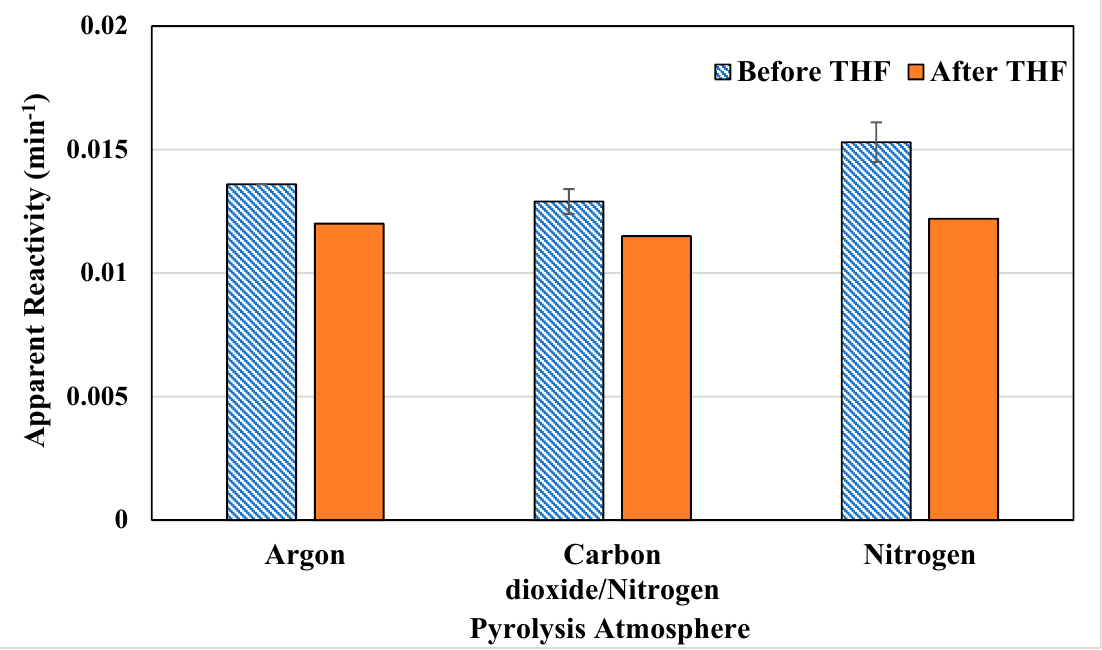
Figure 8 : Apparent reactivity of chars before and after washing with THF (at 875 °C).